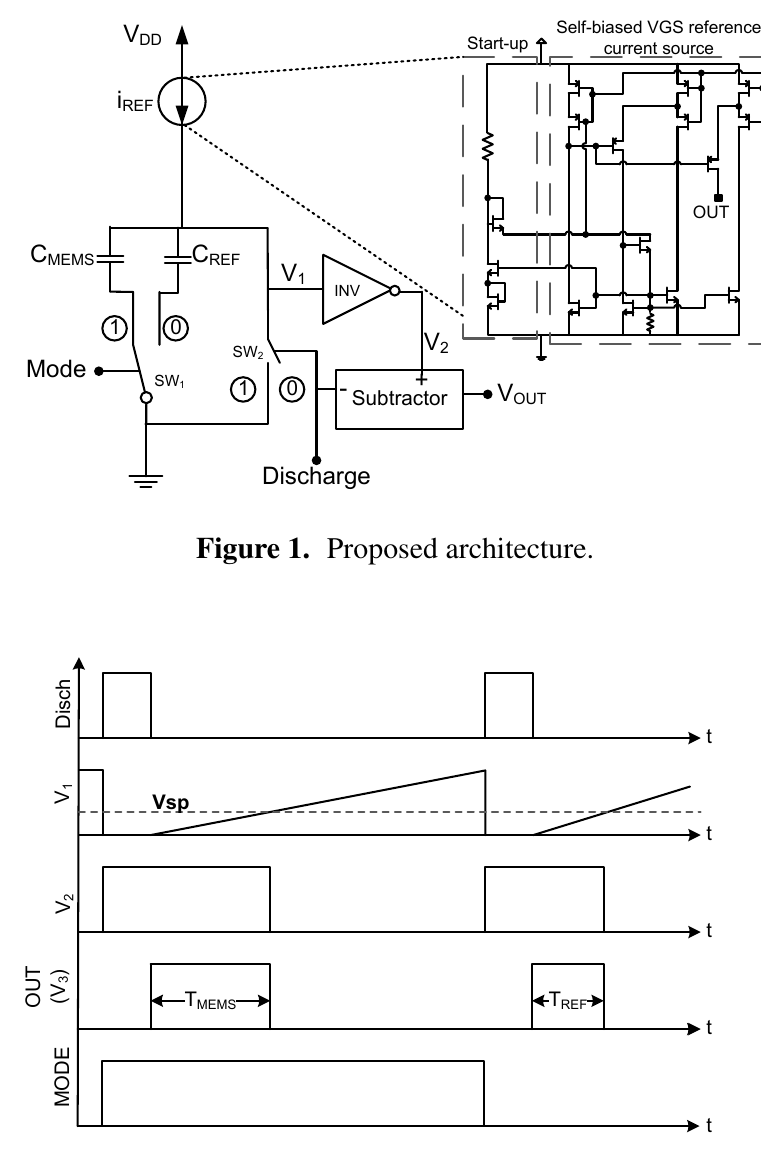
Figure 2. Signal diagram during a